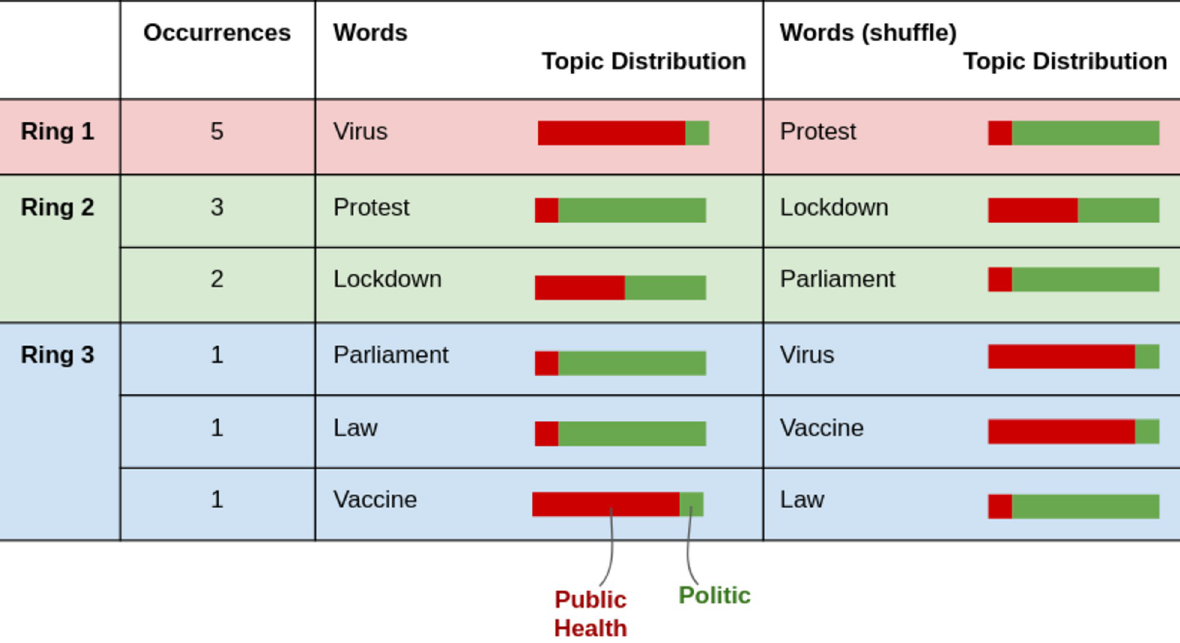
Fig 14. Null model example. The ring sizes and word occurrences are kept, the words are shuffled. In this toy example: O ( e , r 2 ) = 3 + 2, o ( virus , e ) = 5, o 0 ( virus , e ) =